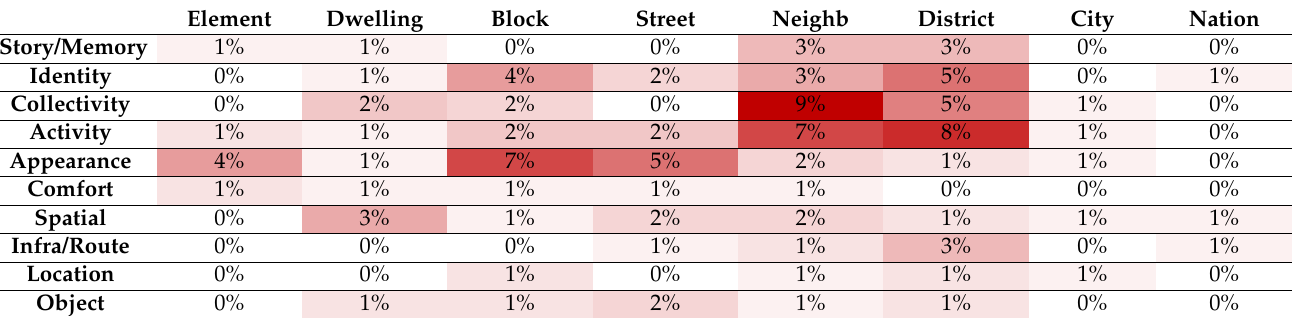
Table A4. Local professionals: seven respondents.